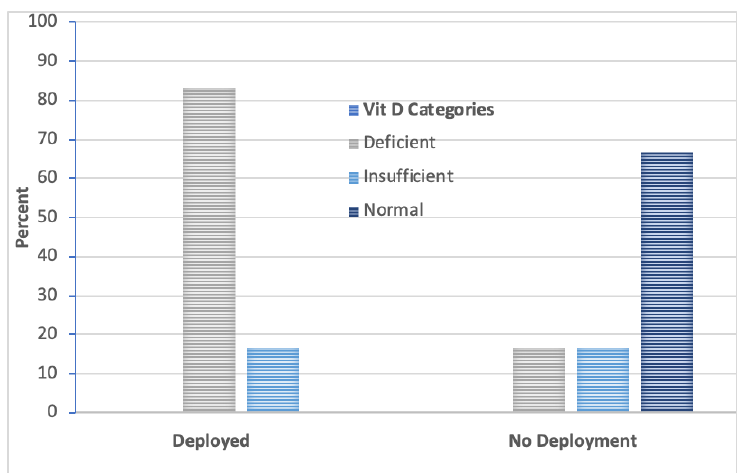
Figure 3. Percent of U.S. Sailors in each of the vitamin D Categories. There was a significant difference ( p = 0.036) in the distribution of vitamin D levels between the deployment groups. ( p = 0.036) in the distribution of vitamin D levels between the deployment